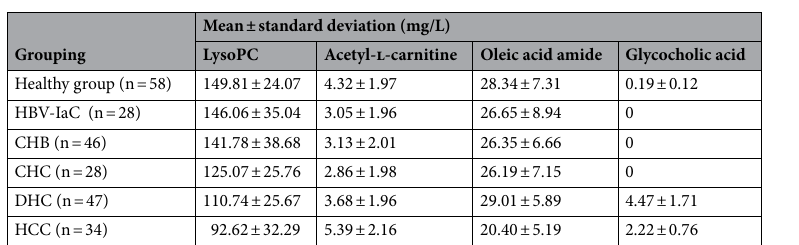
Table 3. Statistical descriptives of lysophosphatidylcholine, acetyl-l-carnitin, oleamide and glycocholic acid: mean ± std.